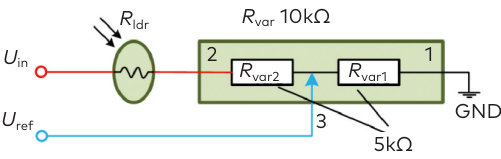
Table 2 denotes an average voltage swing on bright and darker environments.